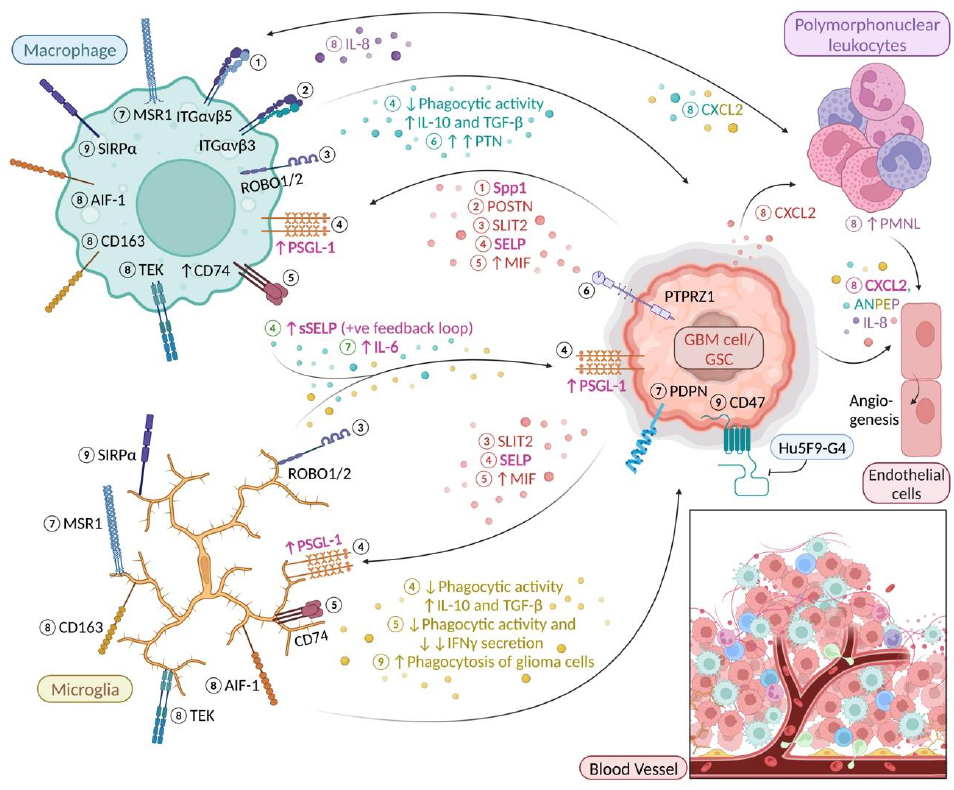
Figure 1. Microglia and macrophage surface molecules and cytokines in glioma. Molecular event ① Glioma cell-derived Secreted phosphoprotein 1 (Spp1) binds to ITGαvβ5 and induces macro- phage recruitment to the TME [19] ② Glioma cell-derived periostin (POSTN) binds to ITGαvβ3 stimulating BMDM to enter the TME from the bloodstream [20] ③ GBM-derived Slit guidance lig- and 2 (SLIT2) binding to Roundabout 1 and 2 (ROBO1/2) mediates microglia/macrophage chemo- taxis [21] ④ GBM-derived SELP interacts with PSGL-1 altering microglia/macrophage phenotype by reducing phagocytic activity while upregulating IL-10 and TGF- β ; exposure to soluble SELP (sSELP) creates a positive feedback loop leading to overexpression of P-selectin (SELP) and P-selec- tin glycoprotein ligand-1 (PSGL-1) by GBM and microglia cells [22] ⑤ Cells belonging to the mon- ocytic subset of myeloid-derived suppressor cells (M-MDSCs) express high levels of CD74 in the presence of glioma-derived Macrophage migration inhibitory factor (MIF); CD74 activation weak- ens the microglial defence against glioma cells [23] ⑥ CD163+ glioma-associated macrophage se- creted pleiotrophin (PTN) supports self-renewal and maintenance of GSCs via PTN – Protein tyro- sine phosphatase receptor type Z1 (PTPRZ1) paracrine signalling [24] ⑦ MSR1+ microglia/macro- phages in GBM upregulate expression of IL-6 and often co-reside with stem-like GBM cells express- ing PDPN [18] ⑧ CD163 and TEK (TIE2) are exclusively expressed by AIF1 (Iba1)+ cells in GBM which contain a higher number of polymorphonuclear leukocytes/granulocytes; CXCL2 has been previously shown to attract granulocytes in mice and was found to be highly up-regulated by both glioma cells (red) and microglia/macrophages (yellow and blue) [25] ; granulocytes were found to be the main source of IL-8 in GBM (purple) [26] stimulating recruitment of macrophages; CXCL2, IL-8 and ANPEP (CD13; blue, yellow and purple) are alternative proangiogenic factors [25 – 28] ⑨ anti-CD47 antibody Hu5F9-G4 promotes microglia/BMDM-mediated phagocytosis of glioma cells by blocking CD47-SIRP α interaction [29 – 31] . Font colour: magenta, “Janus” factors that are secreted by both microglia/macrophages and GBM cells/GSCs (cf. Table 1); green, molecules secreted by both microglia and BMDMs . “Created with BioRender.com”.